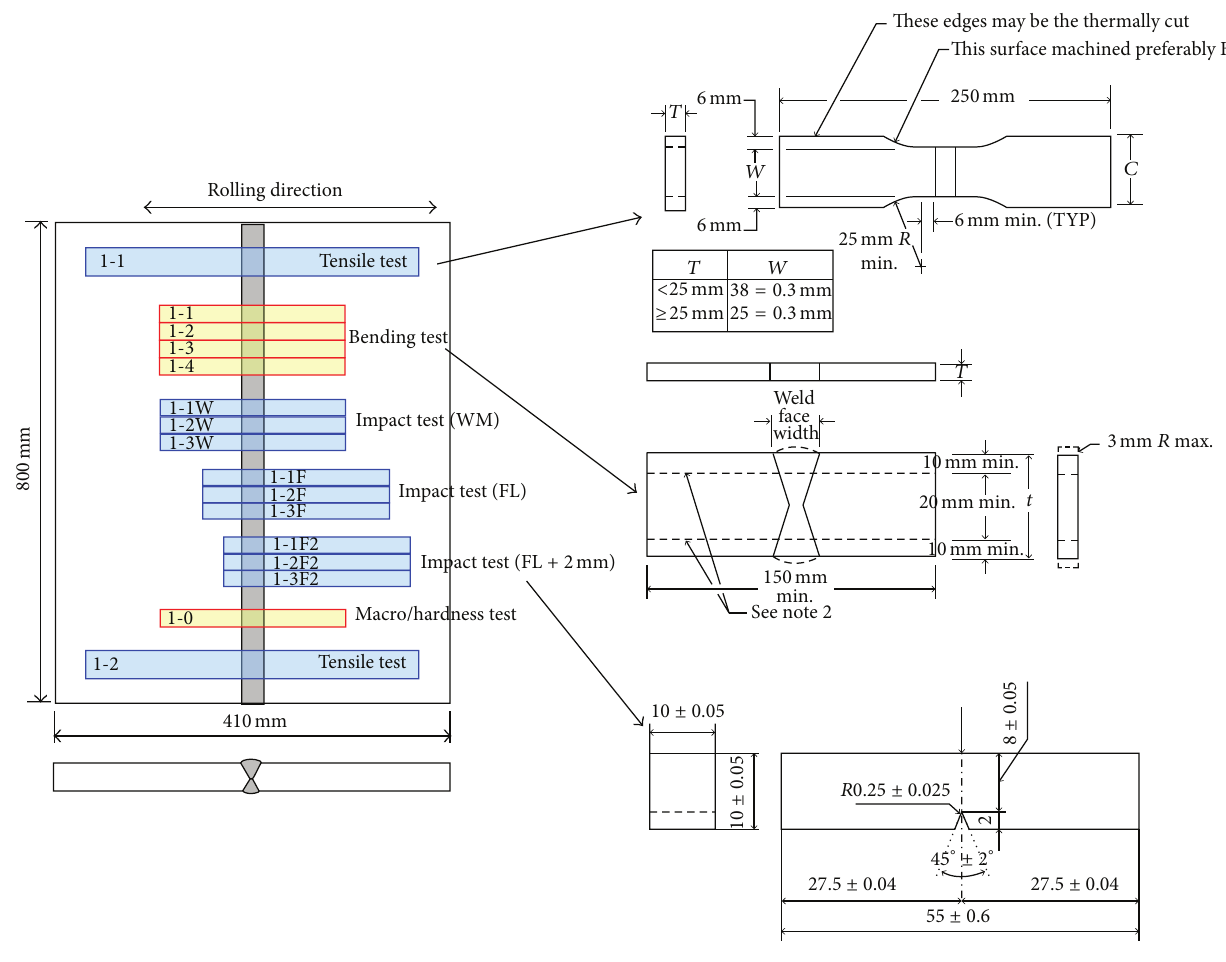
Figure 2: Welding specimen collection drawing and their shape.